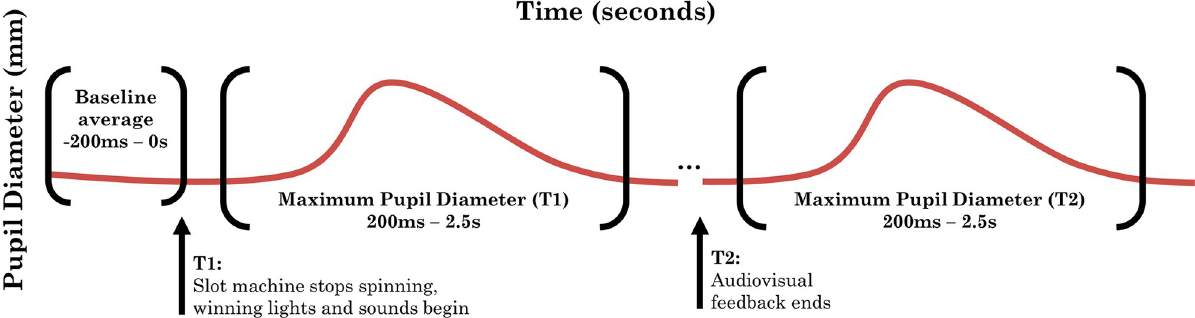
Fig 1. Recording epochs for pupillary responses. Note that on Loss outcomes, there is no ensuing audiovisual feedback and therefore T2 cannot be modelled separately from T1. On the other outcomes, if the duration of audiovisual feedback was less than 2.5 seconds, the T1 and T2 epochs would overlap; see S1 Table for average